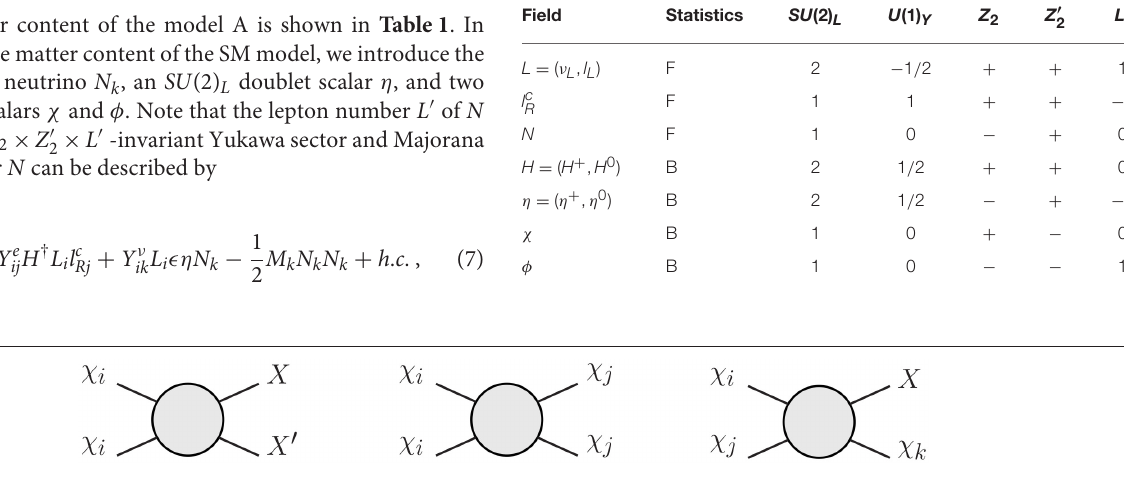
Frontiers in Physics | www.frontiersin.org